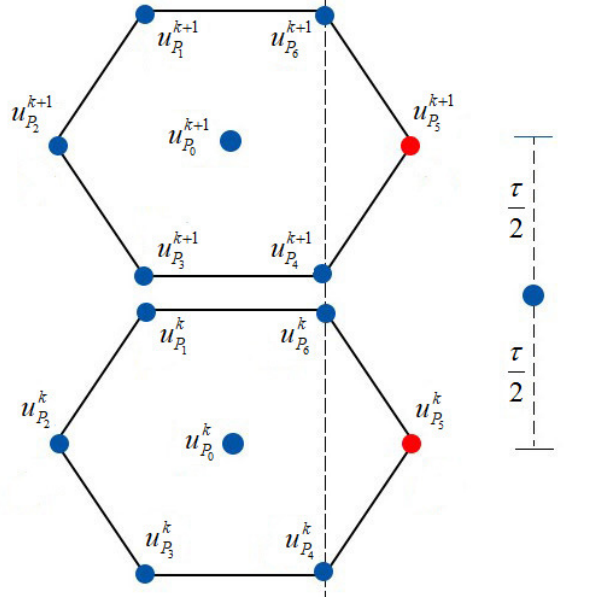
Figure 2. The solution u k